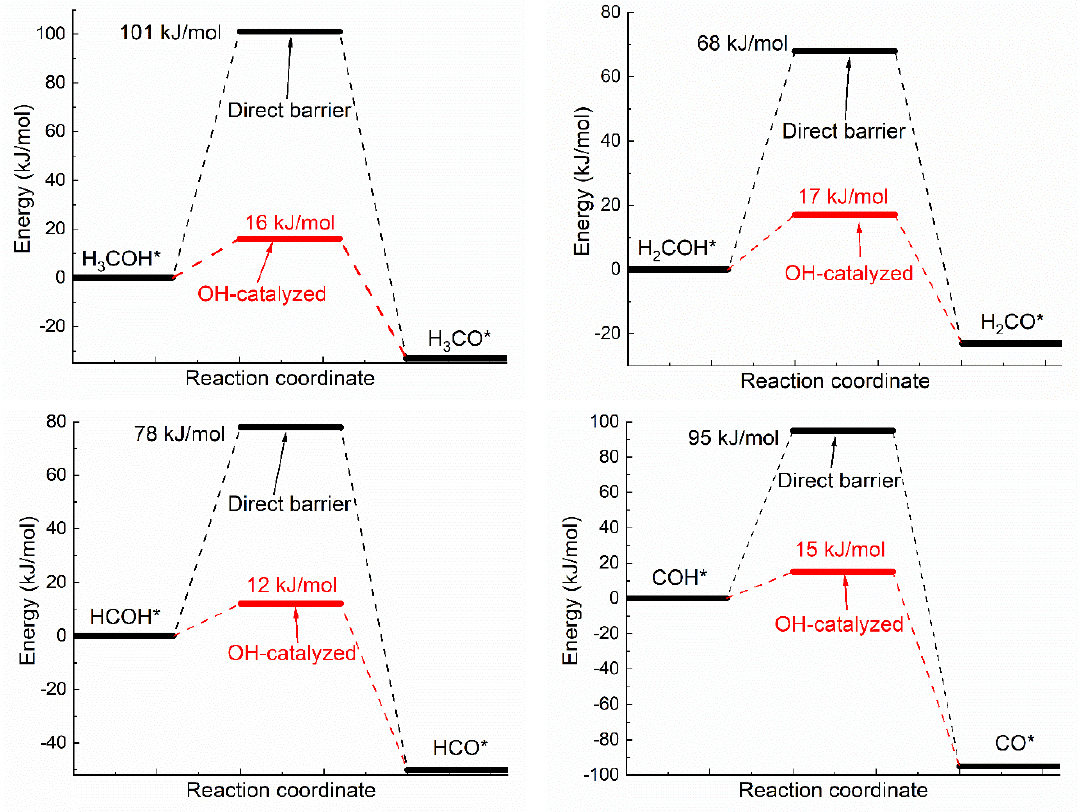
Figure 1. Activation energies of dual path dehydrogenation of oxhydryl in H x CO–H* ( x = 3, 2, 1, 0).